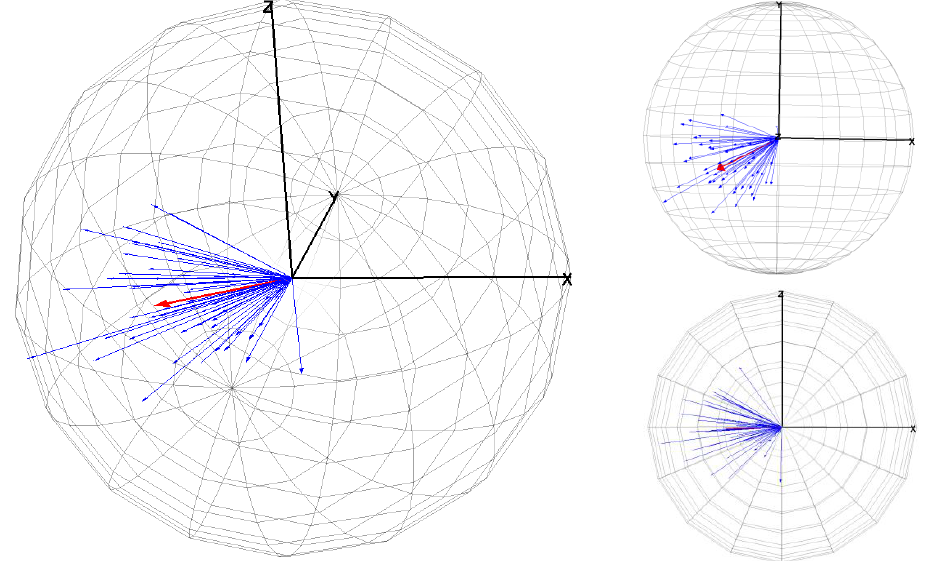
Figure 4. 3D spherical graphic of errors with all vectors in blue and the mean vector in red.